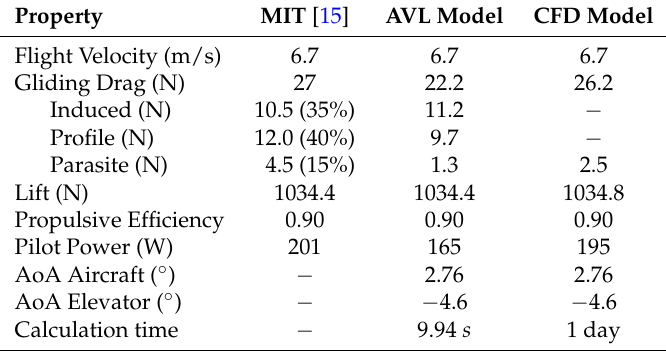
Table 2. Comparison estimated performance of the Daedalus.